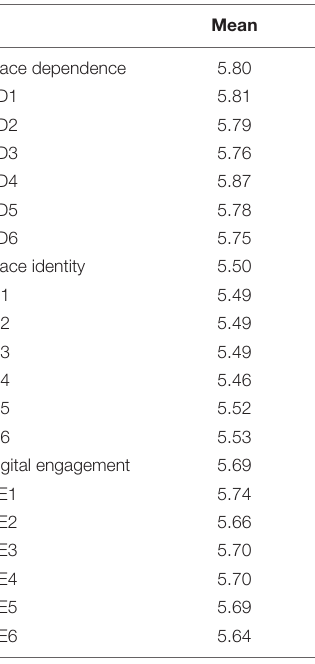
TABLE 3 | Results of confirmatory factor analysis.